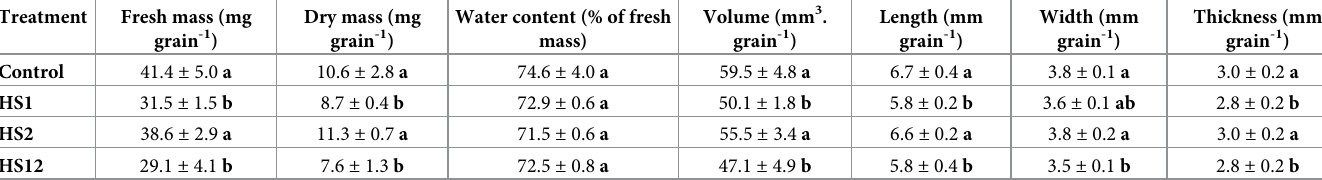
Wheat plants were exposed to heat shock either during the lag-phase (HS1), the grain filling-phase (HS2) or during both lag- and filling- phases (HS12) of grain development. Data are means ± 1 SD ( n = 5 to 10). Within each column, means followed by different letters are significantly different at the 5% level (SNK test).